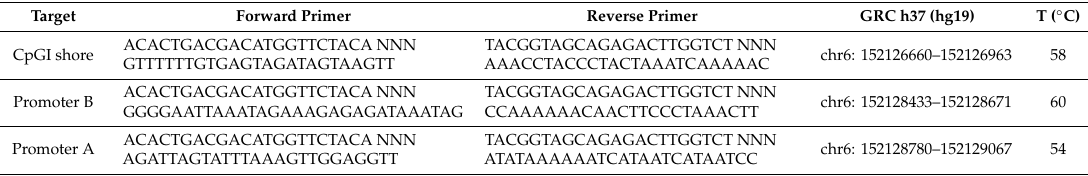
Table 3. Primers used for assessing DNA methylation in the promoter regions of ESR1